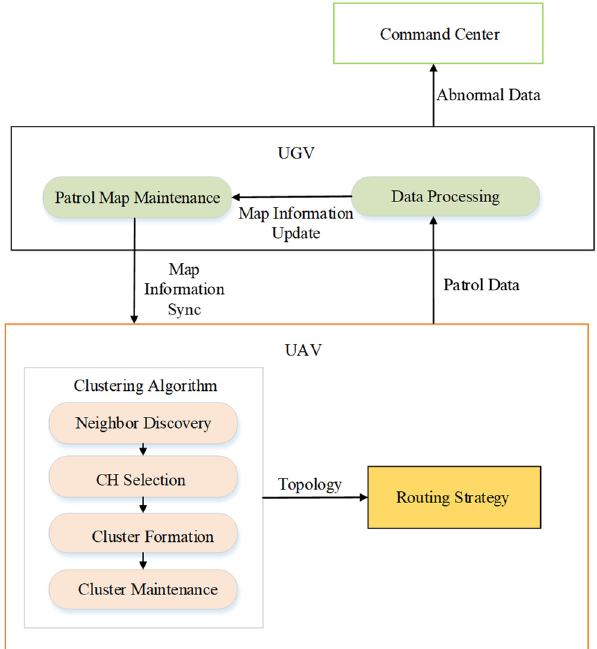
Figure 2. The system framework based on the ground-air cooperative architecture.